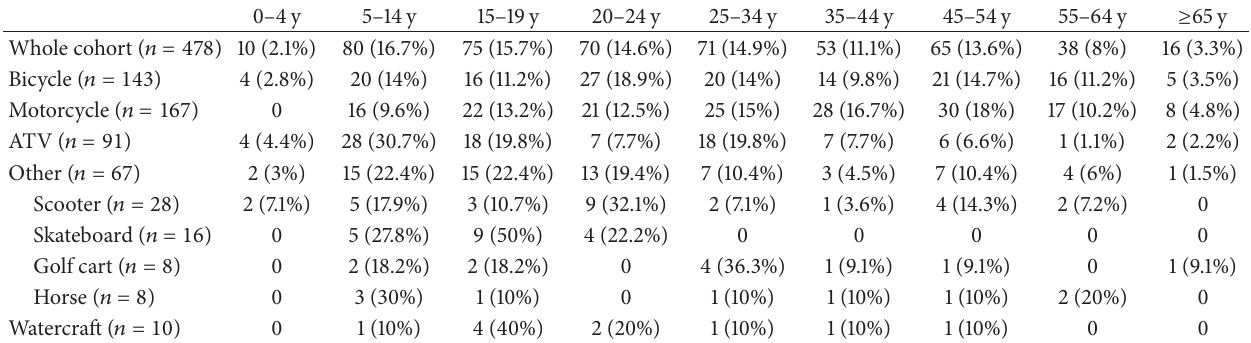
Table 4: Vehicle type by age range.